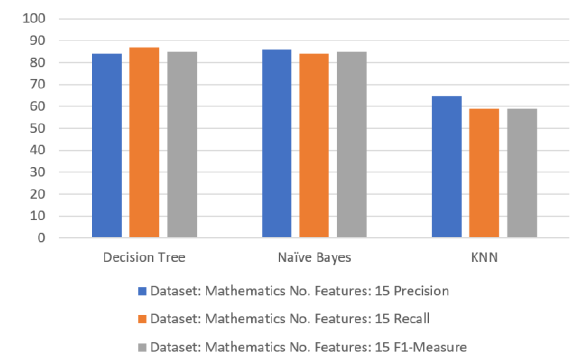
Fig. 4. Classification report comparative graph for Portuguese